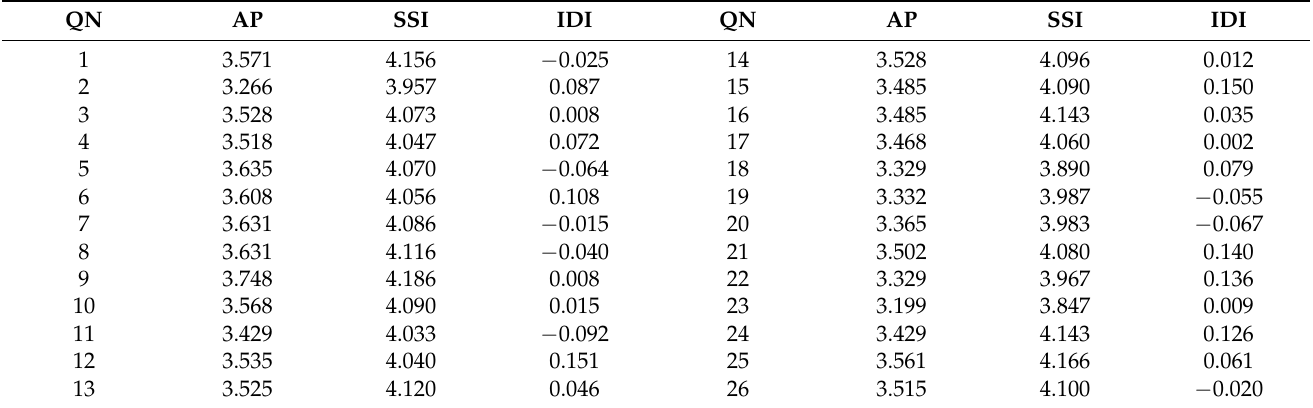
Table 5. Traditional IPA data and Revised IPA data ( n =